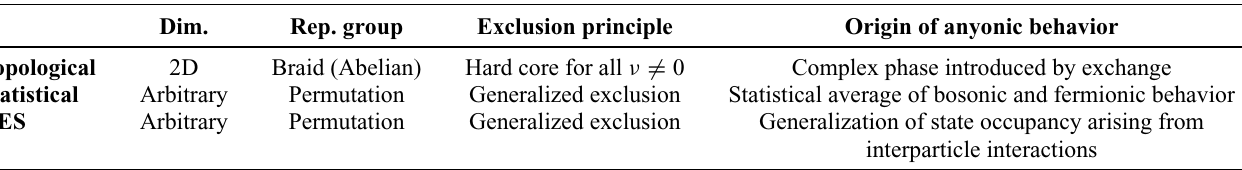
TABLE I. Comparison of the features and behavior of topological, statistical, and GES anyons. Dim. Rep.